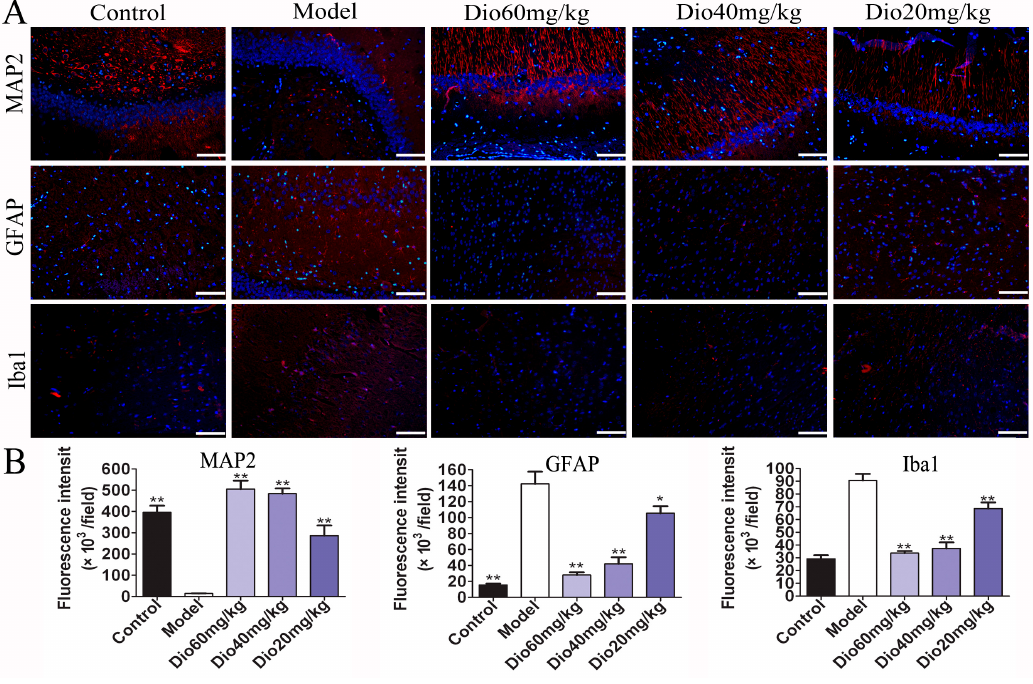
Figure 4. Effects of dioscin on neuropathological changes in aging brain. ( A ) Effects of dioscin on the expression levels of MAP2, GFAP and Iba1 based on immunofluorescence staining (200 × magnifica- tion; Scale bar = 100 μ m). ( B ) Statistical analyses of fluorescence intensity of the positive cells in rat brains. Data are presented as the mean ± SD (n = 10). * p < 0.05 and ** p < 0.01 compared with model groups.